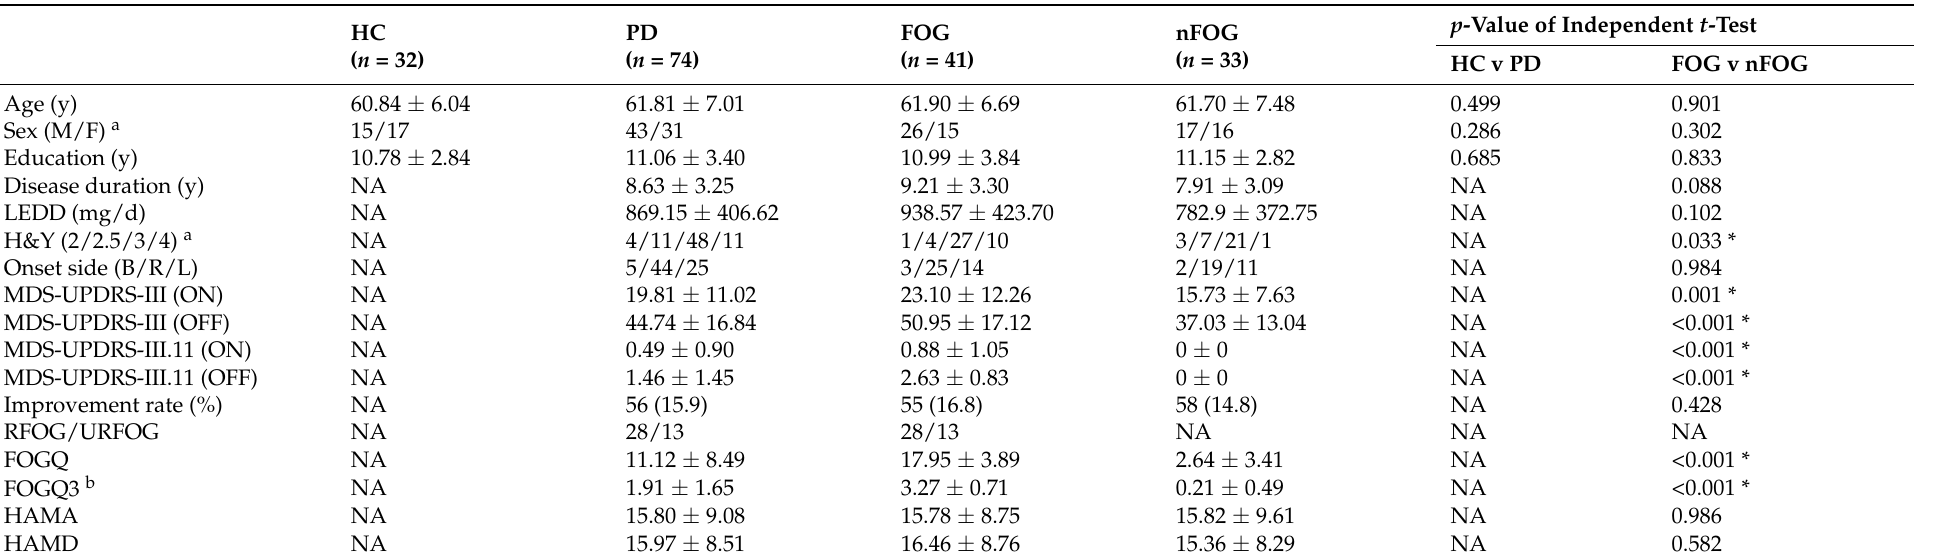
Table 1. Demographic and clinical characteristics of all